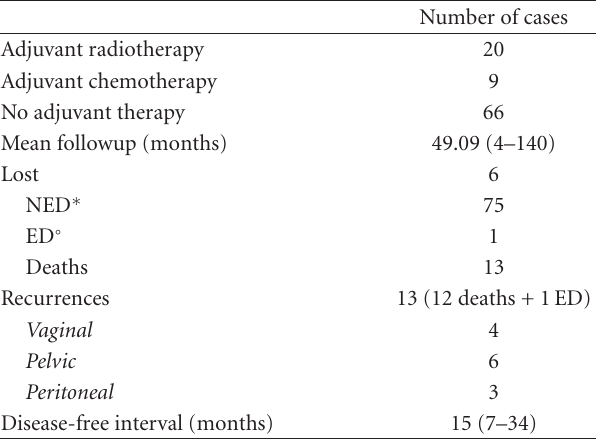
Table 3: Adjuvant therapy, followup, and survival.